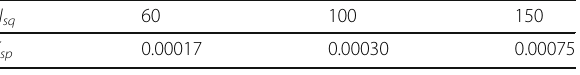
Table 2 Variation of K sp according to N sq